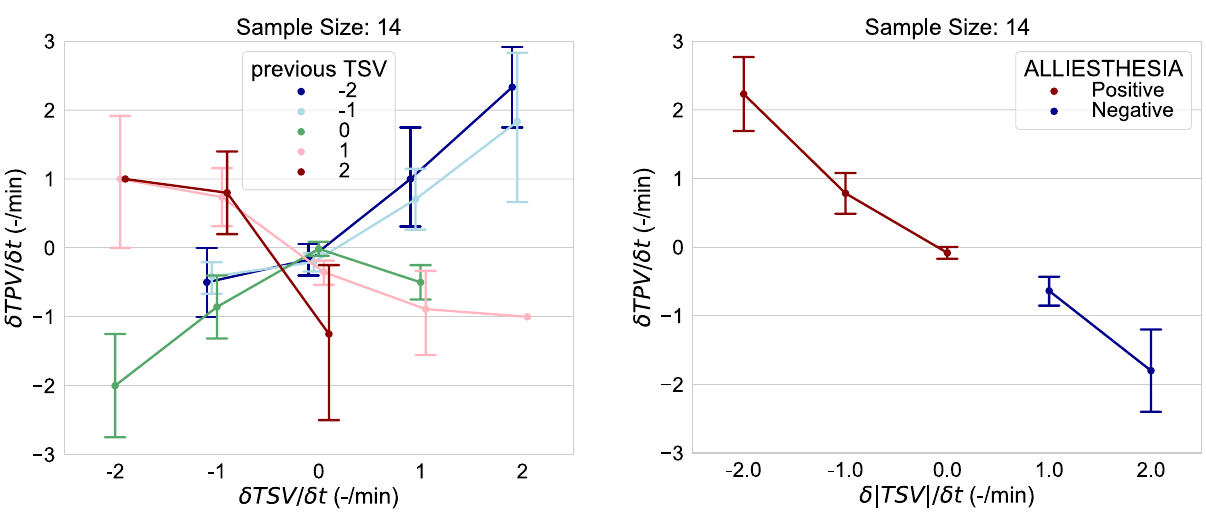
Figure 9. Rate of change of thermal pleasure as a function of the rate of change of thermal sensation (left) and rate of change of thermal pleasure as a function of the rate of change of the absolute value of the thermal sensation vote (right). Error bars represent one standard